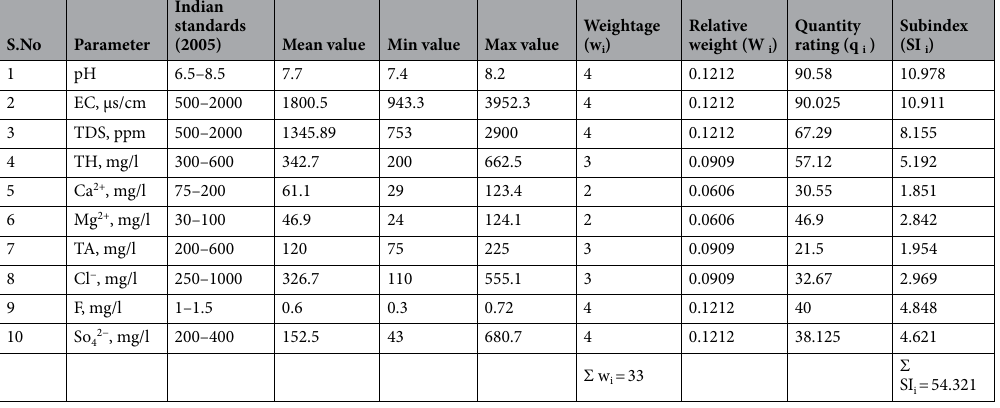
Table 5. Water quality index determination for